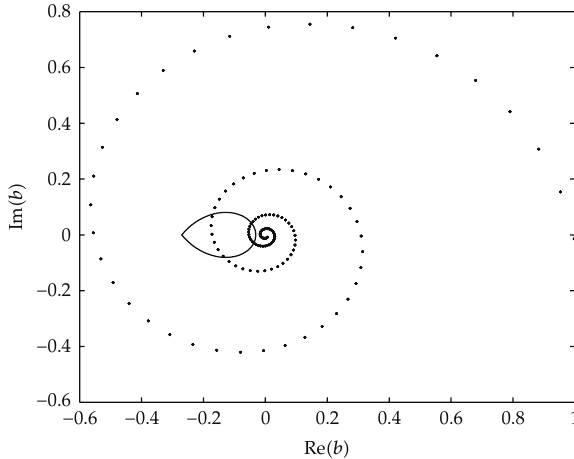
Figure 6: The stability oval and points M (cid:5) s (cid:8) for Example